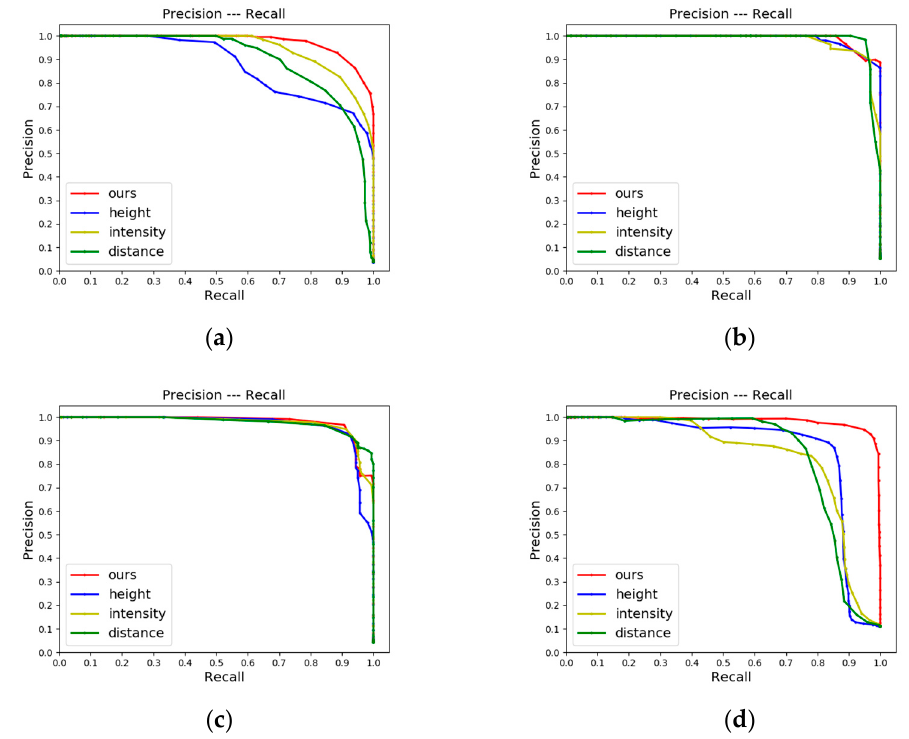
Figure 12. P-R curves of CMCD, single-channel projection of height, intensity, and distance on JLU datasets: ( a ) P-R curve of jlu00; ( b ) P-R curve of jlu01; ( c ) P-R curve of jlu02; ( d ) P-R curve of jlu03.